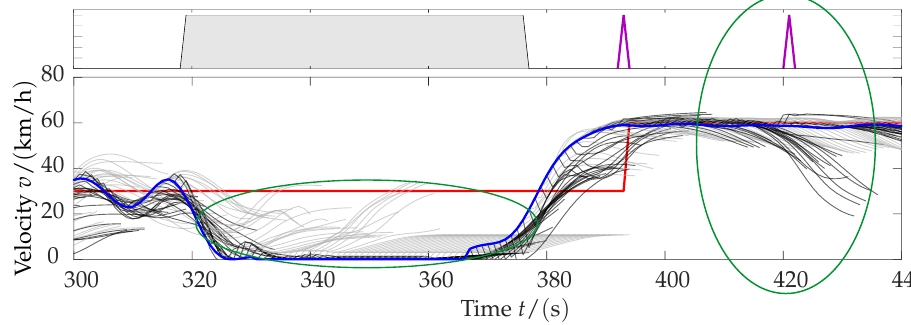
Figure 14. Second exemplary test sequence using ED-LSTM 20 s prediction horizon